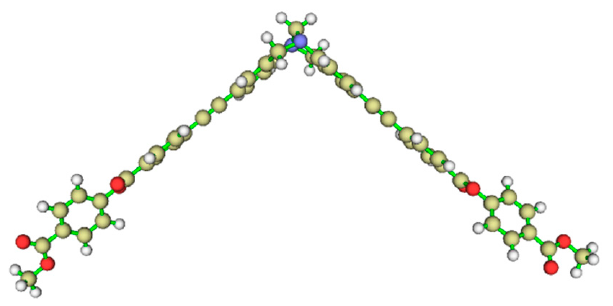
Figure 2. The optimized structure of 8 calculated by Gaussian 09 program using the B3LYP method with the 6-31G + (d,p) basis set [51].